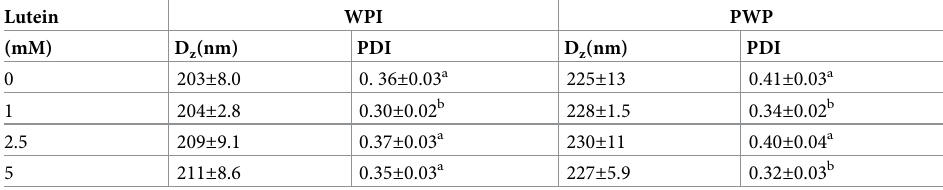
Table 2. Effect of different lutein concentration on the particle size of emulsions.